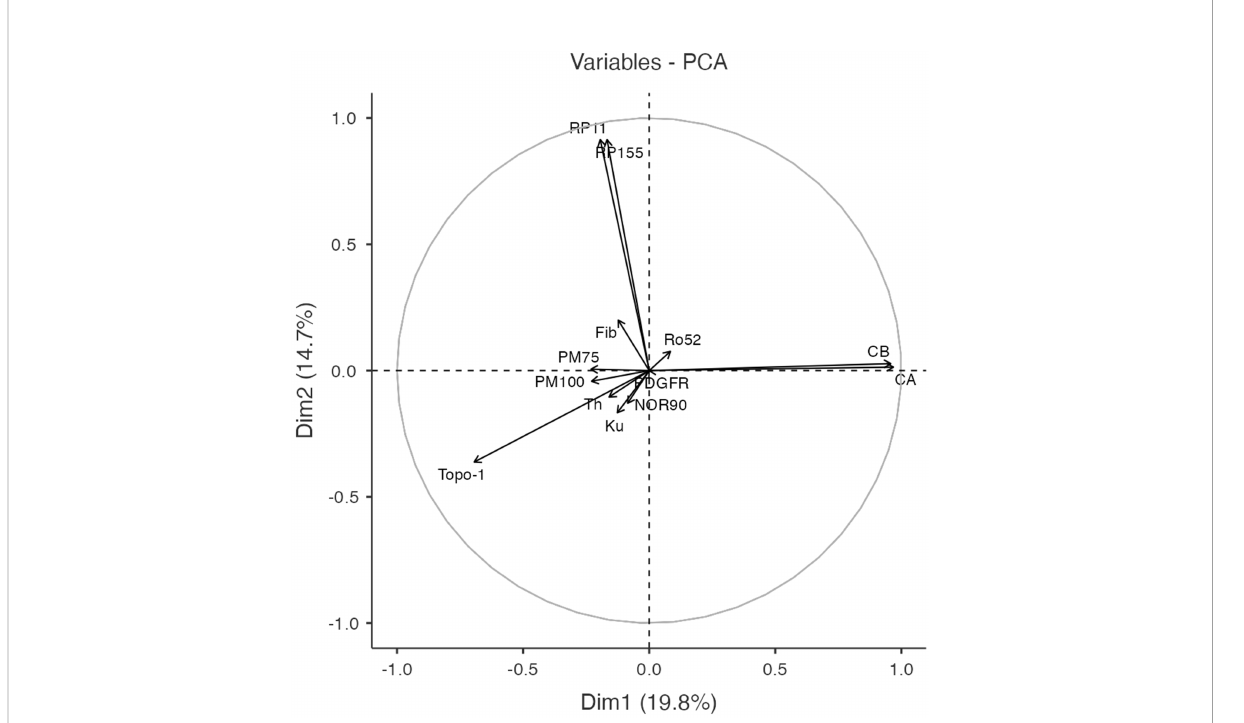
FIGURE 1 Correlation circle plot of the fi rst 2 dimensions (Dim 1 and Dim 2) of the principal components analysis, which accounted for 34.5% of the total variance. This plot illustrates strong correlations between RNA polymerase 3 (RP3) epitope 11 and epitope 155 as well as between ACA epitopes.